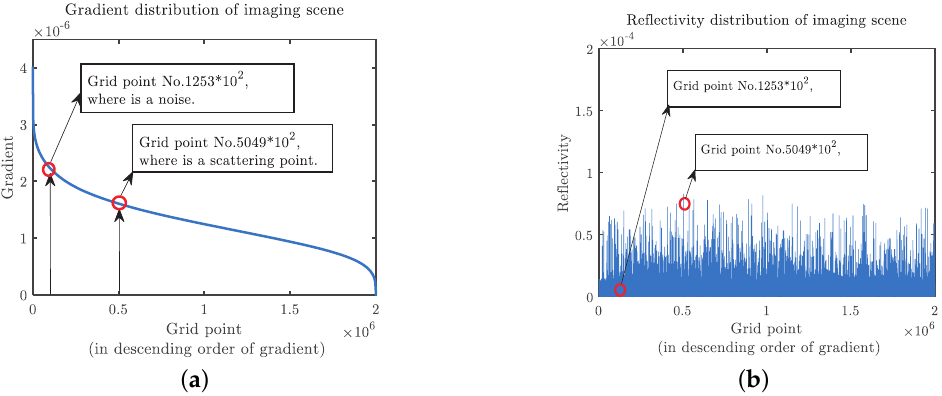
Figure 4. Diagram of target scene reflectance distribution. ( a ) Gradient distribution of imaging scene. ( b ) Reflectivity distribution of imaging